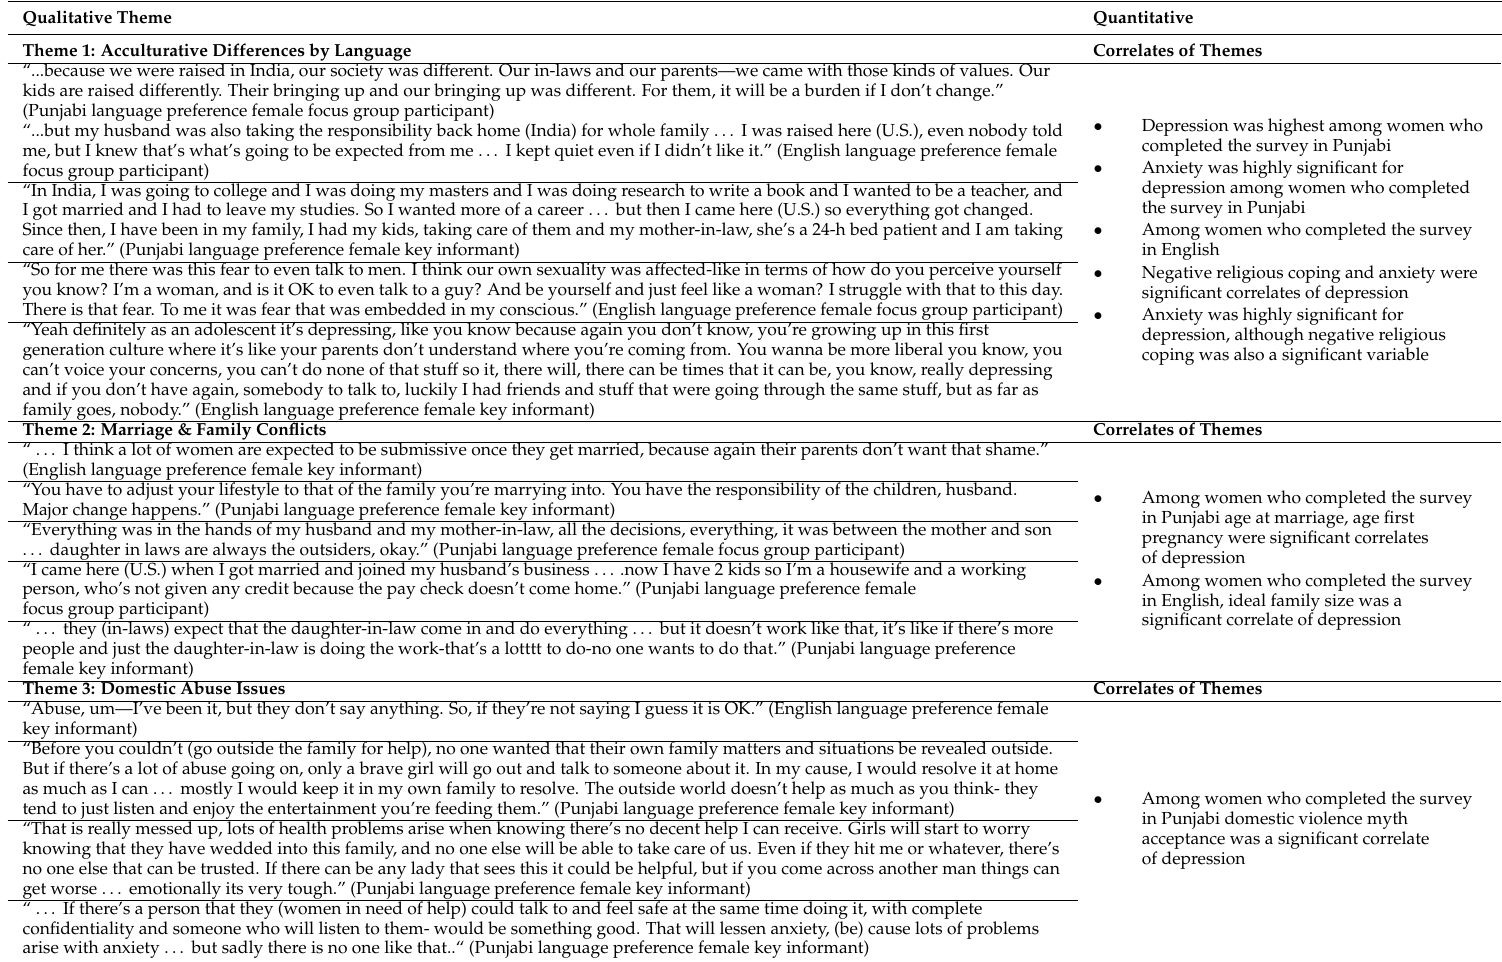
Table 5. Qualitative contextual data aligned with variables related to